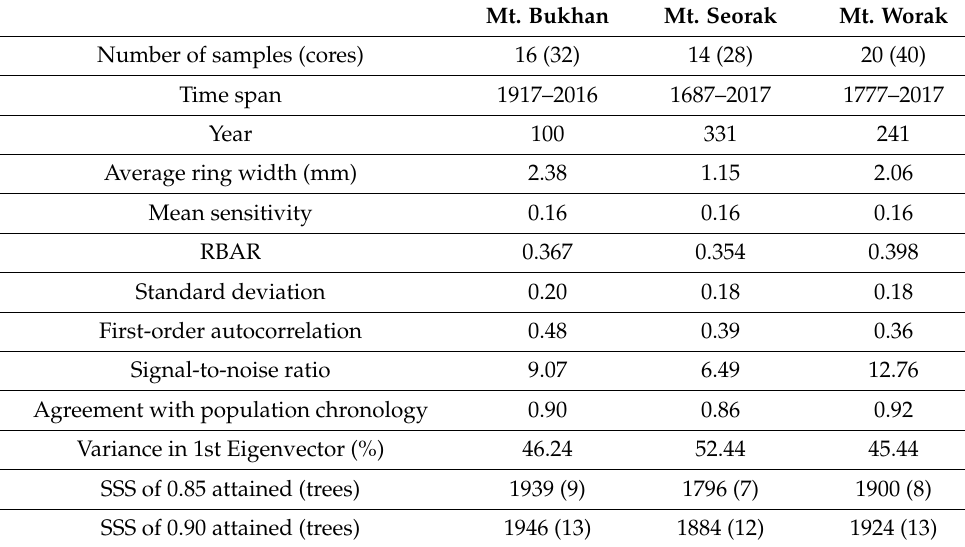
Figure 3. The chronology and sample depth of P. densiflora from Mt. Seorak (dotted line is SSS ≥ 0.85).